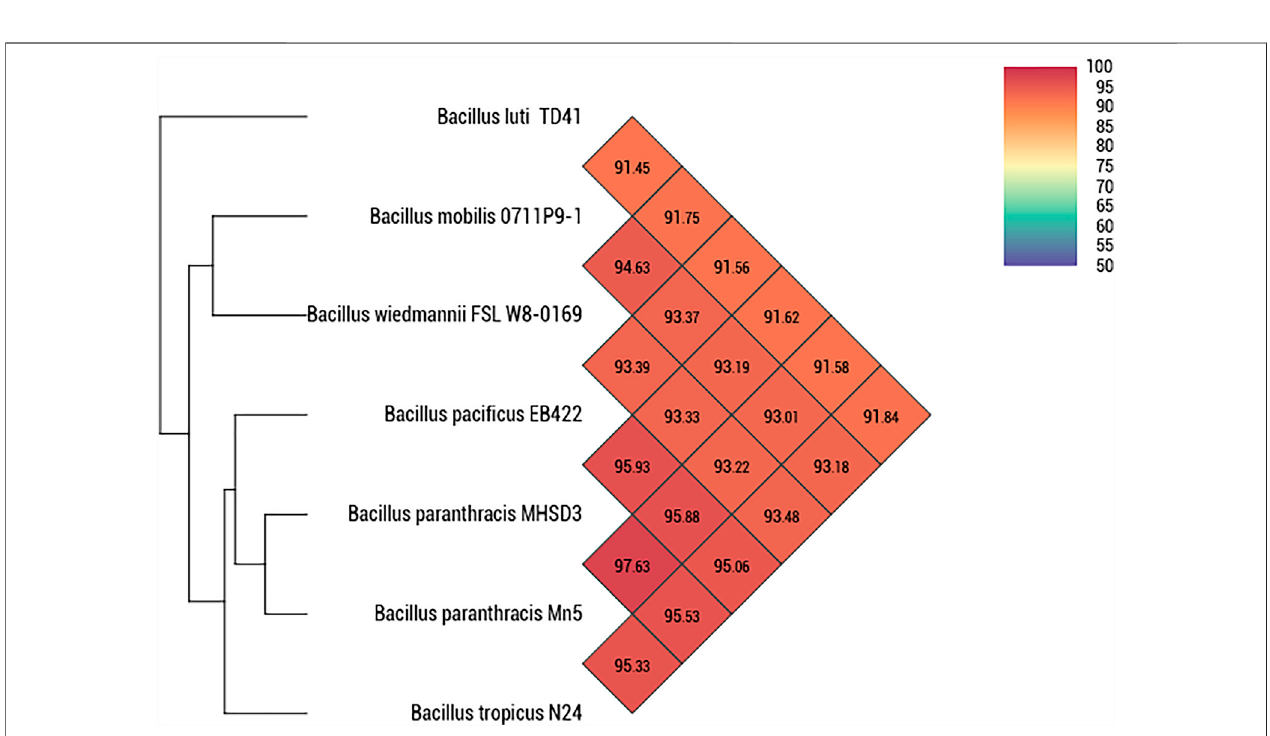
FIGURE 2 | Heatmap generated with OAT software indicating Orthologous Average Nucleotide Identity values calculated between Bacillus paranthracis strain MHSD3 and other closely related B. cereus species.